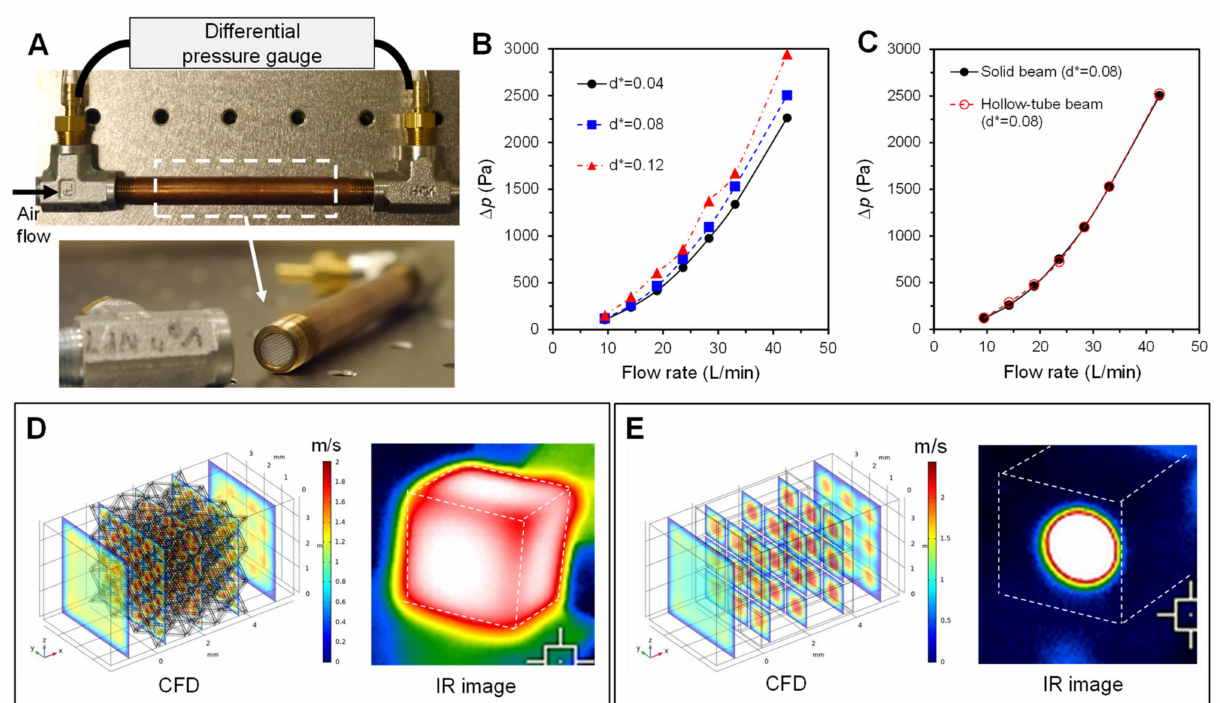
Figure 3. ( A ) Schematic of the test setup. Pressure drop of the polymer microlattice with solid beams ( B ) and hollow-tube ceramic microlattices ( C ). Flow distribution of the 3D microlattice ( D ) and monolith structure ( E